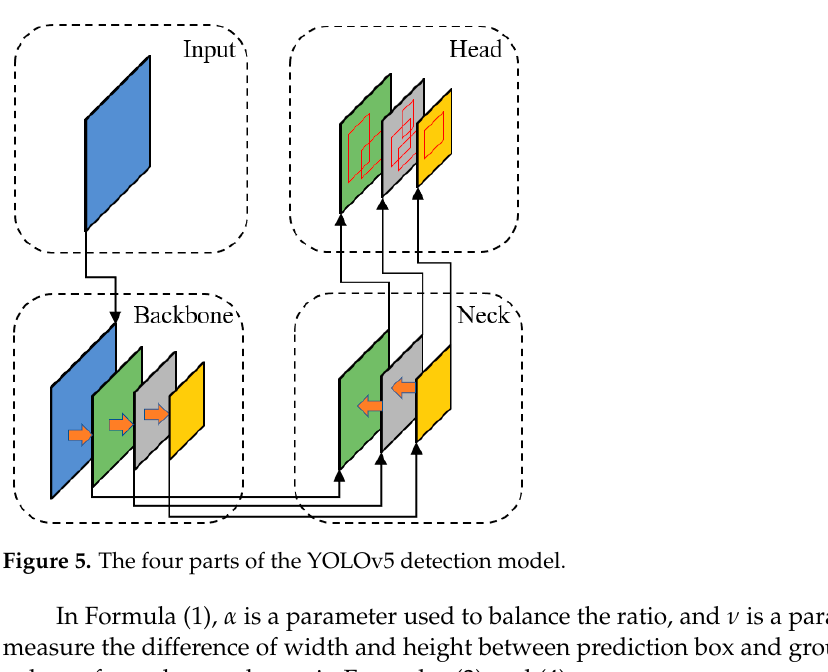
Figure 5. The four parts of the YOLOv5 detection model.